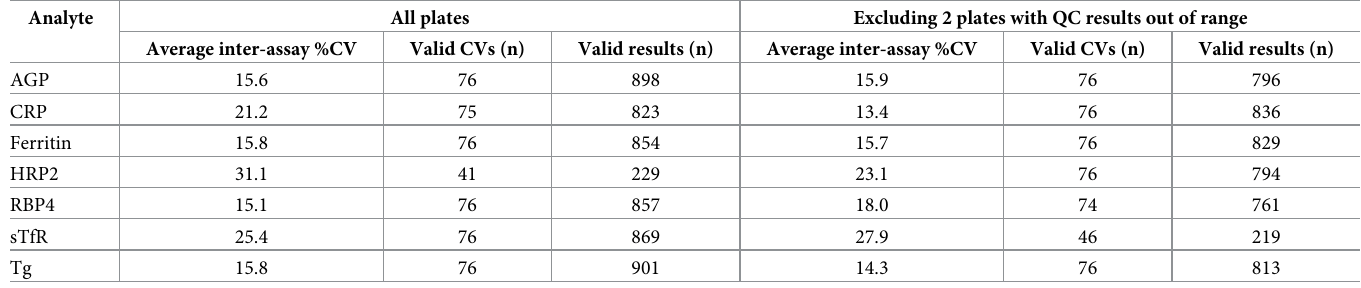
Table 3. Inter-assay CV calculated using 76 heparin plasma samples tested in 7 labs. Analyte All plates Excluding 2 plates with QC results out of range Average inter-assay